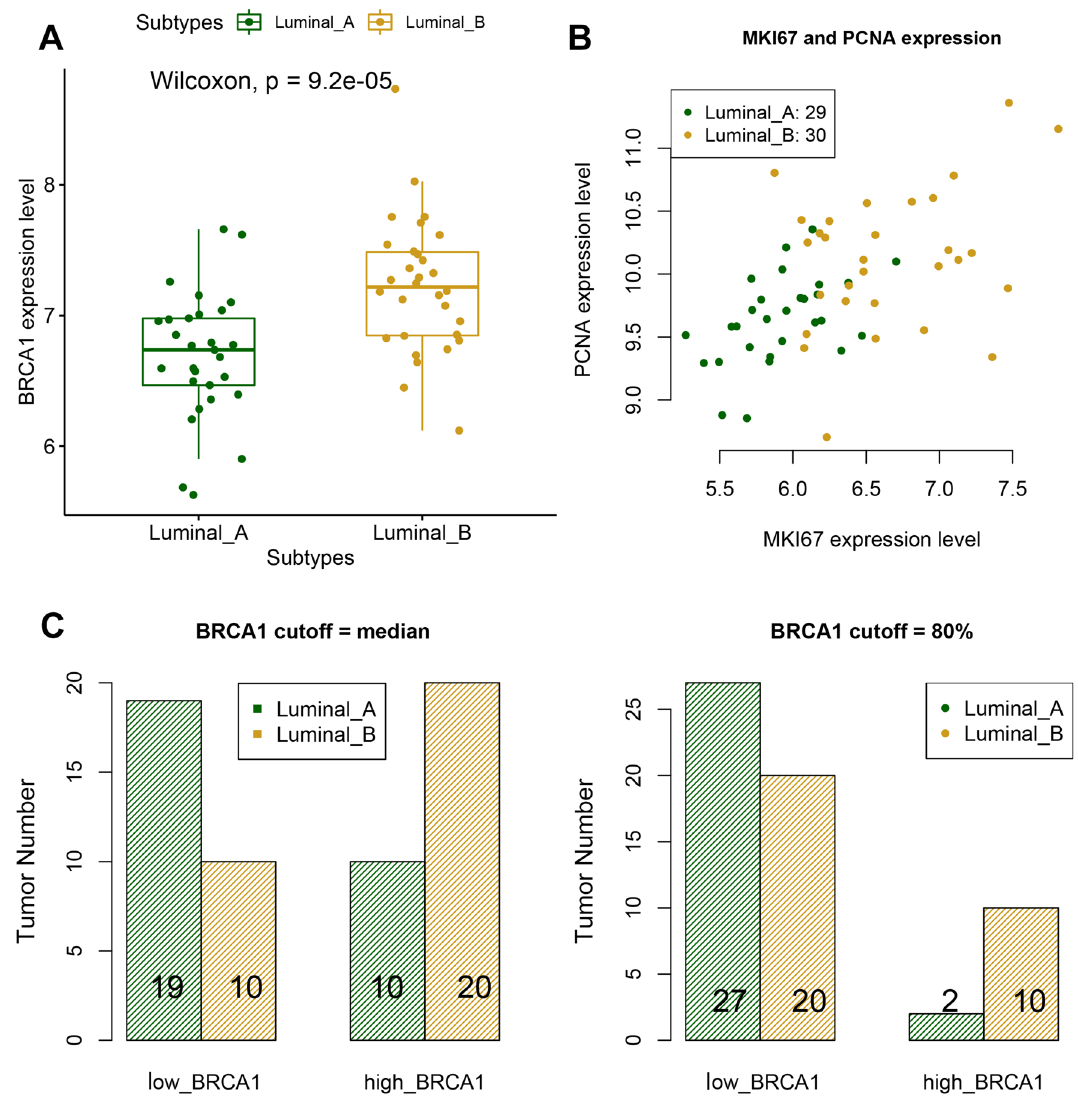
Figure 1. Luminal tumors in dataset GSE45827. ( A ) Boxplot of BRCA1 expression in luminal A and B tumors (p value < 0.001, the Wilcoxon rank sum test), ( B ) Scatterplot of MKI67 and PCNA expression levels in luminal A and B tumors, ( C ) Bar graph of luminal A and B tumor numbers in low- or high- BRCA1 groups (left panel: cutoff = median of BRCA1 expression levels, Fisher’s exact p value = 0.019, right panel: cutoff = 8th decile of BRCA1 expression levels, Fisher’s exact p value =